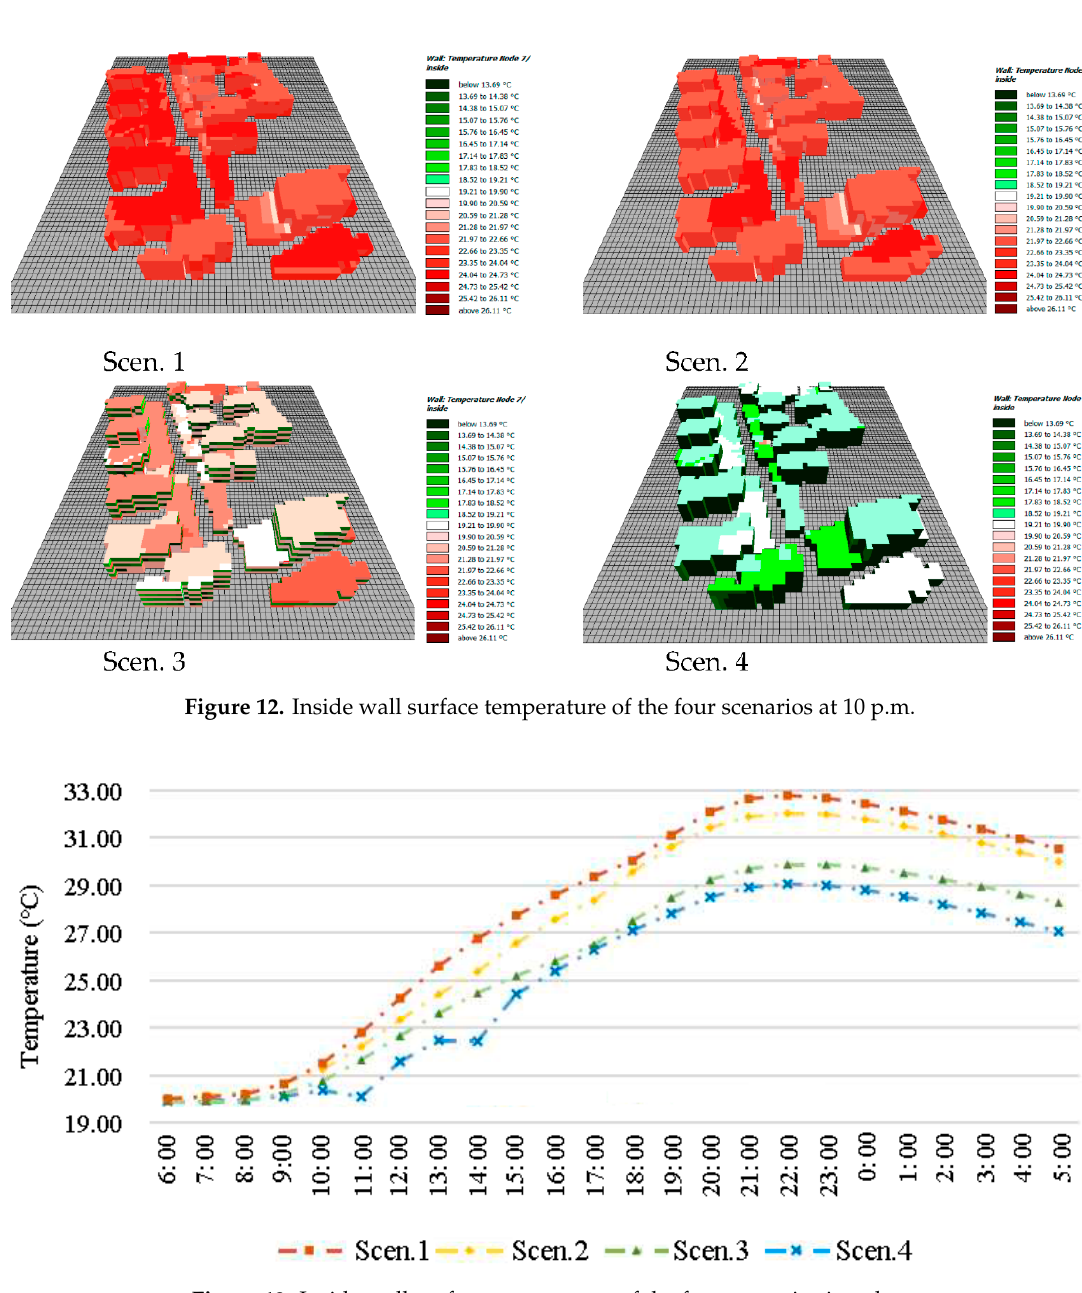
11 of 17 Figure 11. The outside wall surface temperature of the four scenarios at 4 p.m. In summary, the outside wall temperature varied greatly, even reaching up to roughly 60 °C. Comparing with the out wall temperature, the cooling performance of any green walls were negligible. 3.4. Cooling Performance on inside Wall Surface Temperature